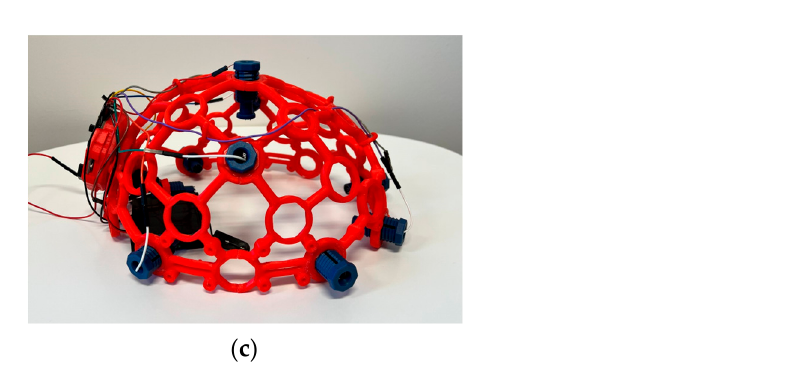
Figure 2. ( a ) Programmable Logic Controller (S7-314, Siemens), ( b ) an actuator in which we control two positions, movement to the right and to the left, ( c ) EEG headset (OpenBCI).